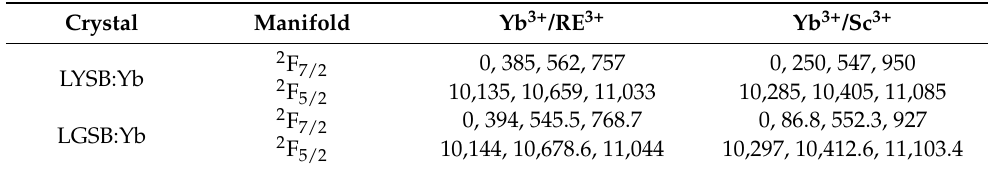
Table 11. Positions of the Stark levels of Yb 3+ centers in LYSB:Yb [44] and LGSB:Yb crystals [46]. Reprinted with permission from ref. [44], copyright 2020, Elsevier.